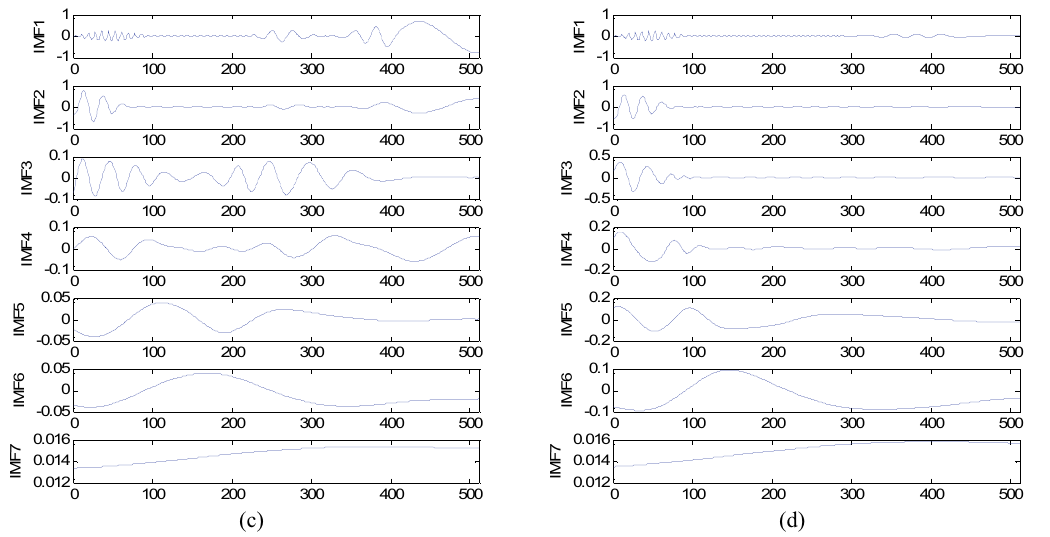
Fig. 4. The IMFs of four kinds of signals (a) No flaw (b) Delamination (c) Debonding (d) Void